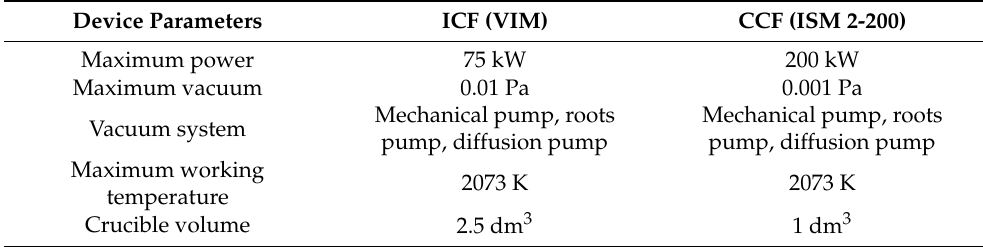
Table 3. Technical and construction parameters of the aggregates used in the present